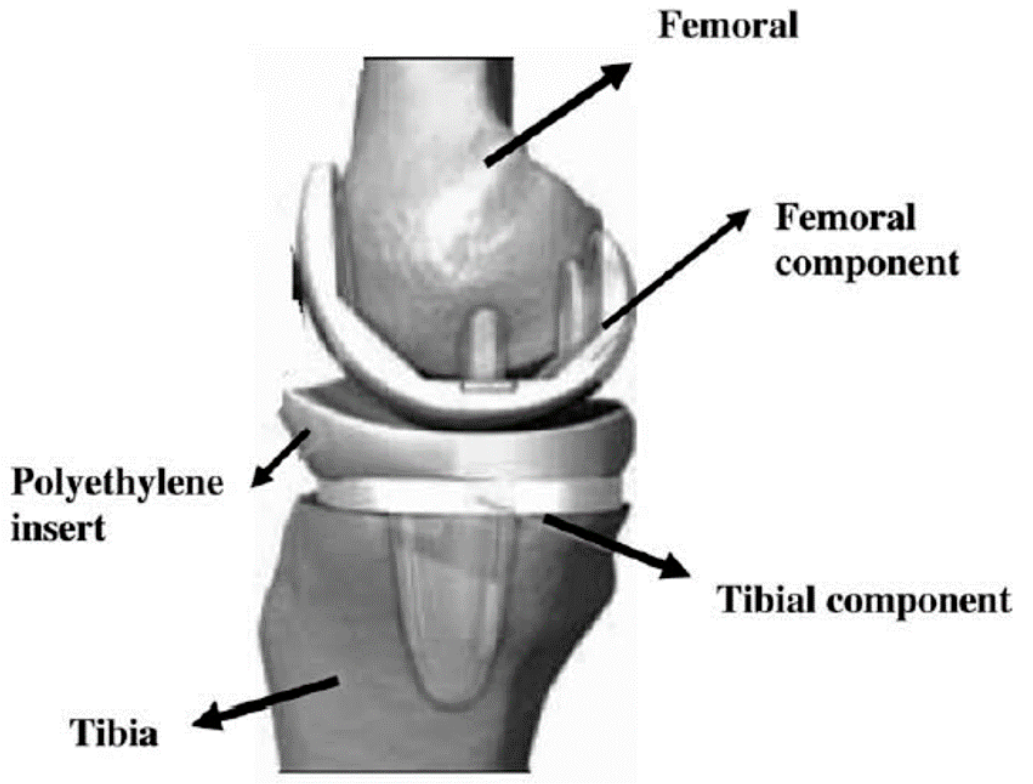
Figure 2. Knee implants replacements (reprinted with permission from ref. [9]. Copyright 2009 Else- vier).